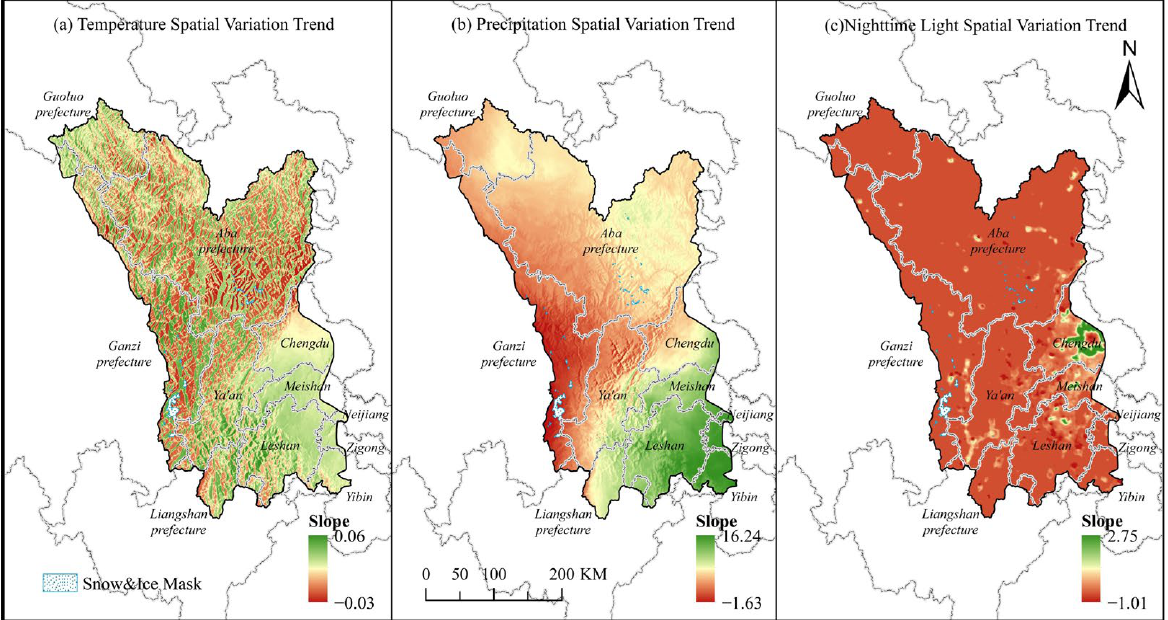
Figure 7. Trends of average temperature, accumulated precipitation and nighttime light during the growing season in the Minjiang River Basin from 2001 to 2020.